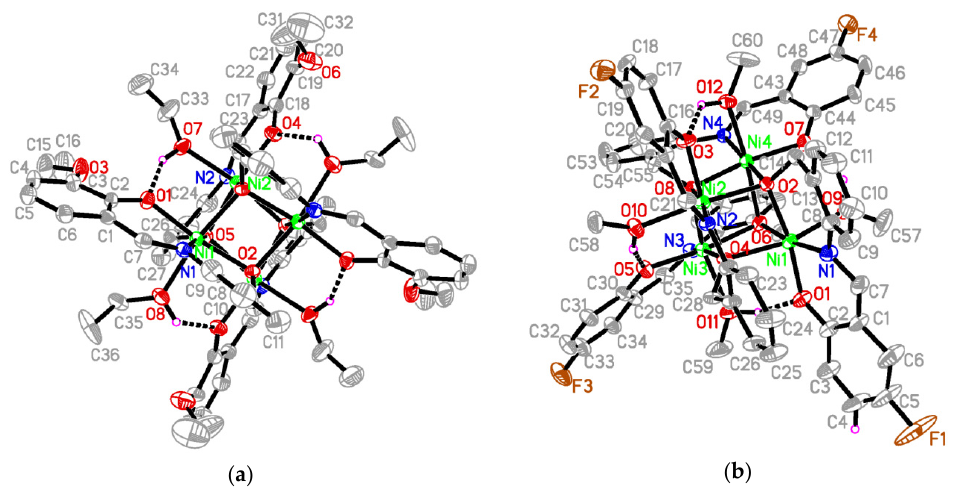
Table 3. Hydrogen bond distances (Å) and bond angles ( ◦ ) for complexes 1 and 2 .